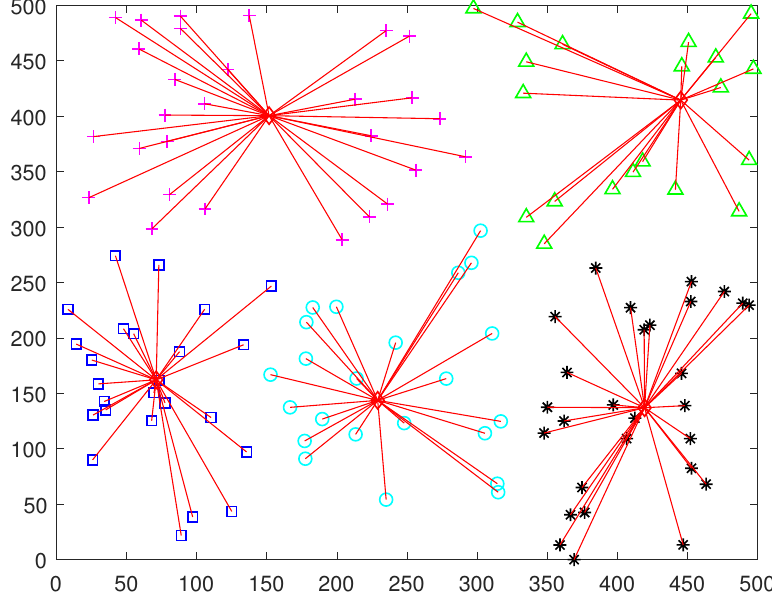
Figure 3. Topology of WSN and result of sensor associaton by